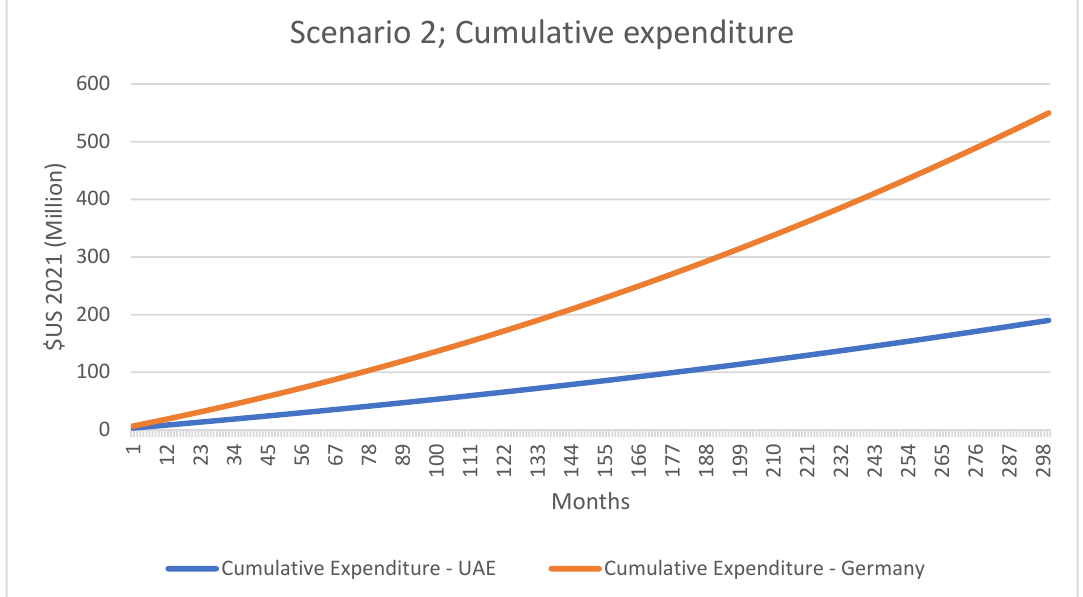
Figure 10. Cumulative expenditure through electricity consumption for UAE and DE under scenario 2.